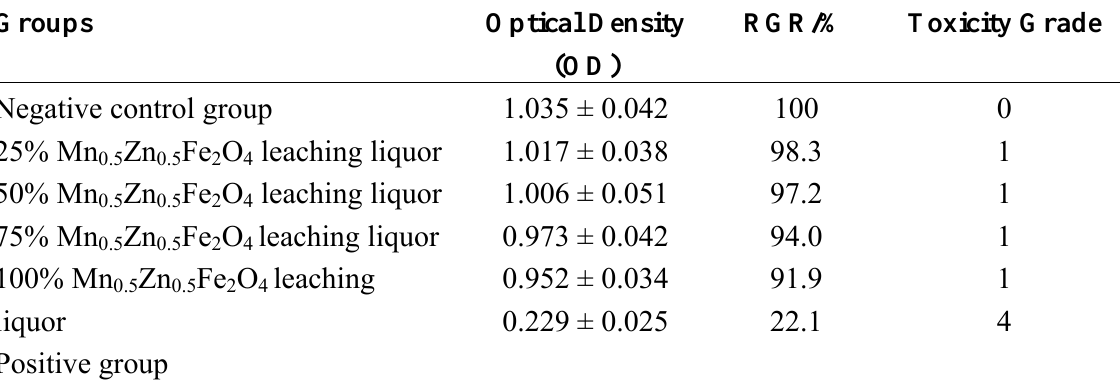
Table 1. The results of cytotoxicity of Mn assay( ± s, n =